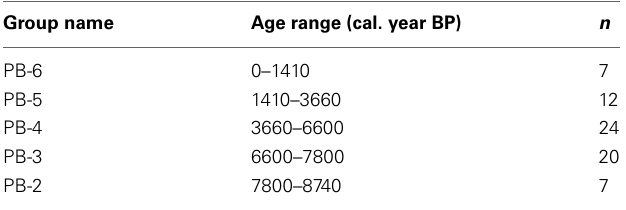
Table 1 | Groups of samples for ANOSIM analysis with age range of groups and sample size for each group.